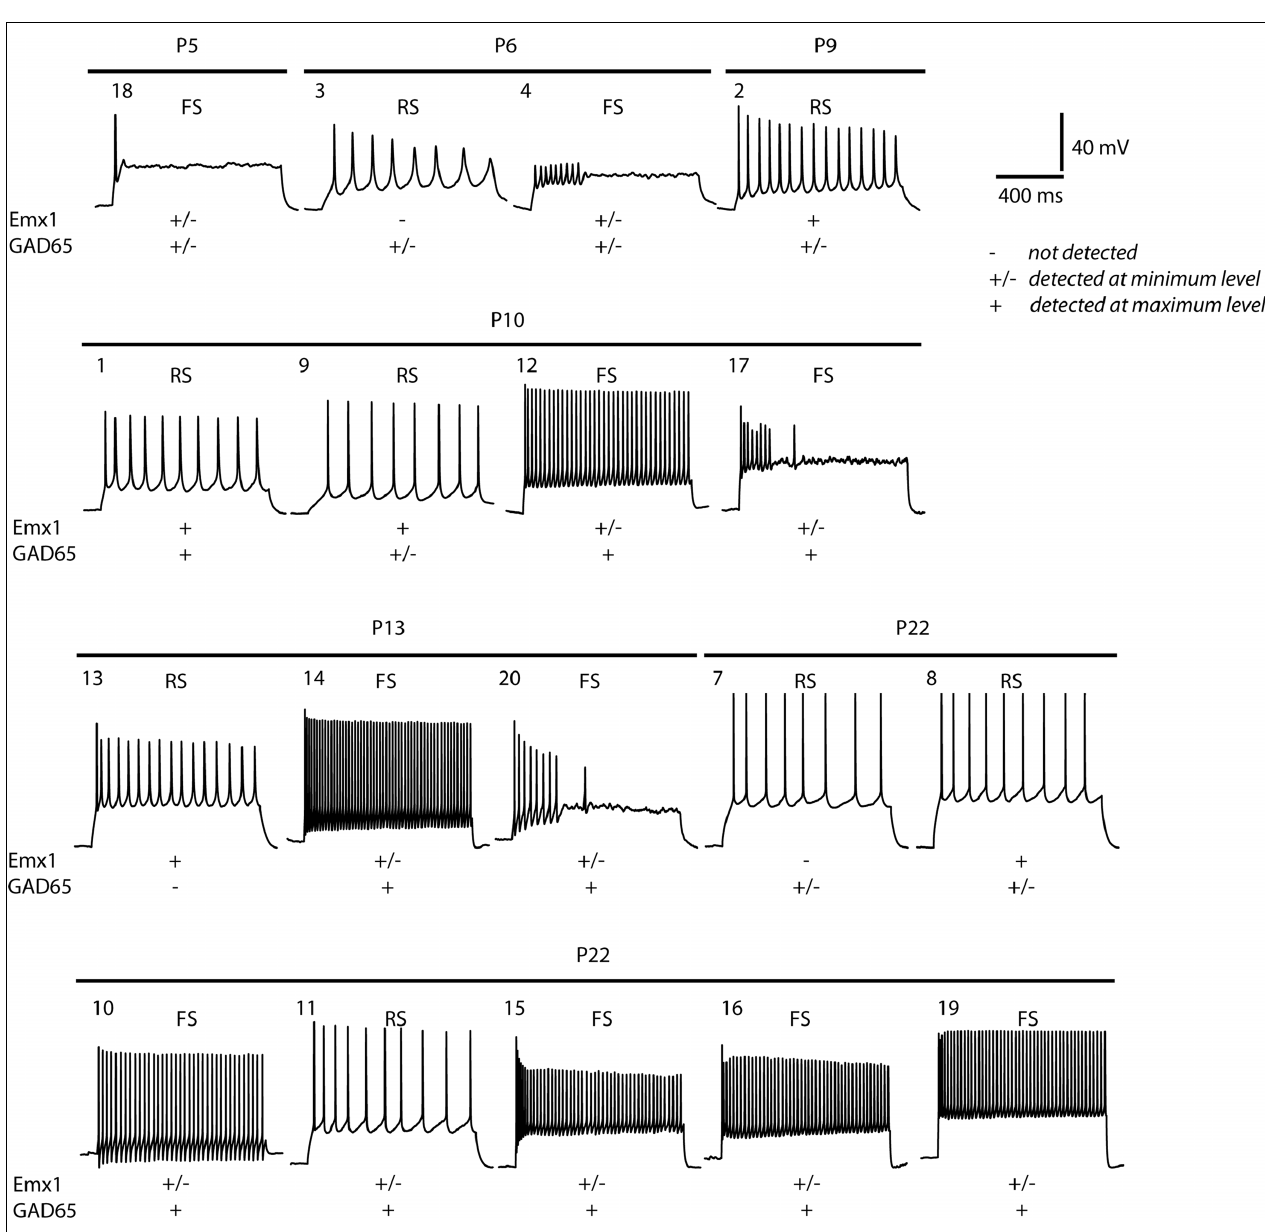
FIGURE 3 | Typical fi ring patterns of the 18 layer II/III neurons analysed and their corresponding expression of pyramidal cell (Emx1) and interneuron (GAD65) markers. Expression levels: − , not detected; + / − , detected at low level; + , robustly detected. Cell numbers refer to the cell numbering system reported in Table S1 in Supplementary Material and used throughout the